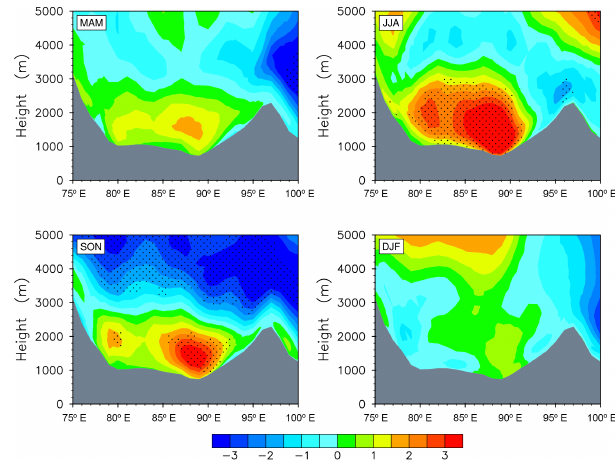
Figure 10. Seasonal longitudinal cross sections of daily wind com- posite difference between high and low AOD days along 40 ◦ N. Stippled areas are significant at the 95% level. Gray areas repre- sent